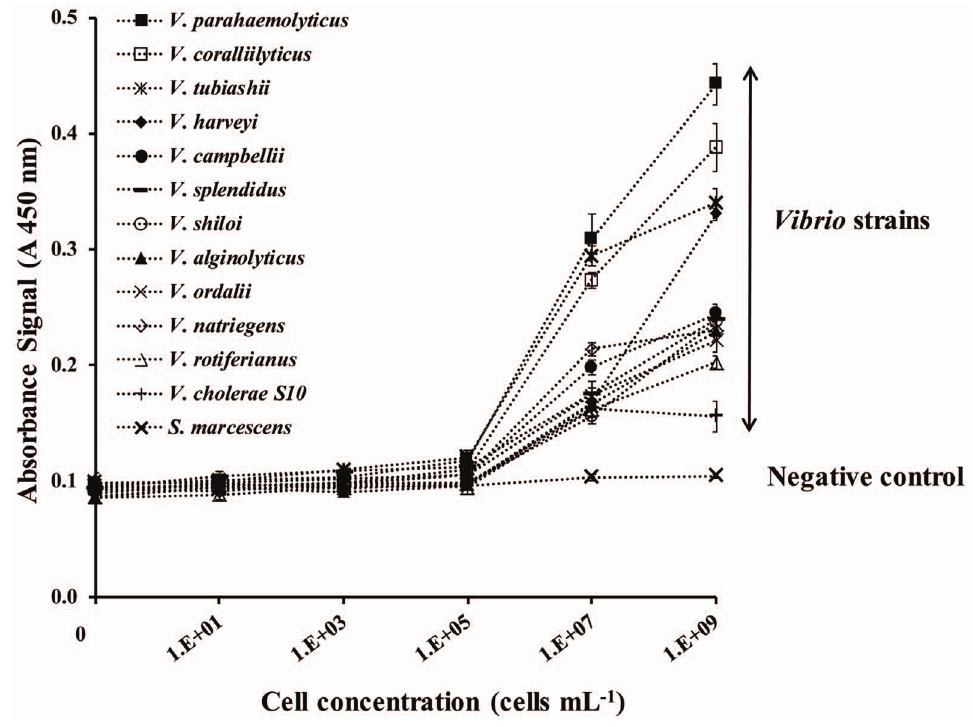
Figure 2. Antibody affinity for different Vibrio strains. Absorbance signals obtained after direct adsorption of bacterial strains to the well surface for one hour followed by detection using a 1/500 dilution of horseradish peroxidase anti- Vibrio antibody (HRP- a Vib Pab) incubated for one hour onto the surface.